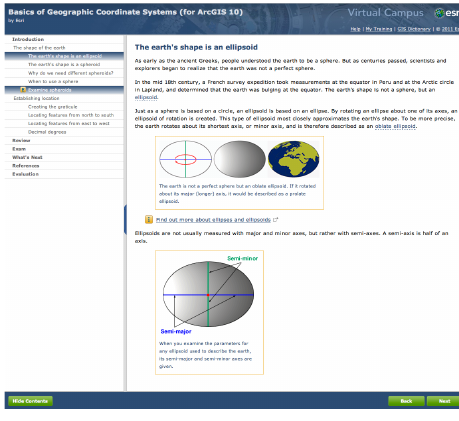
Figure 9: ESRI – Free Web Course: Basics of Coordinate Systems